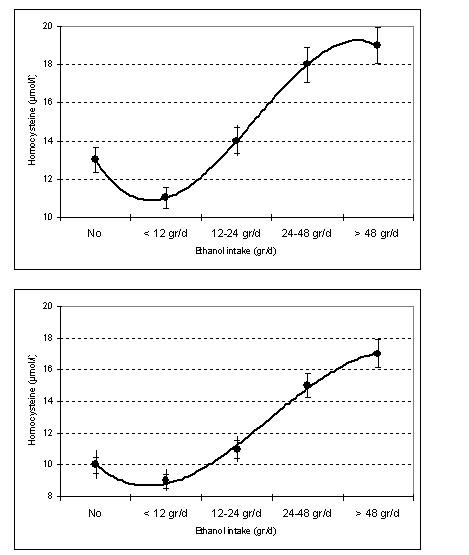
Homocysteine levels by daily ethanol intake in males (upper figure) and females (power figure) (continuous line is a 3rd order interpolating polynomial)